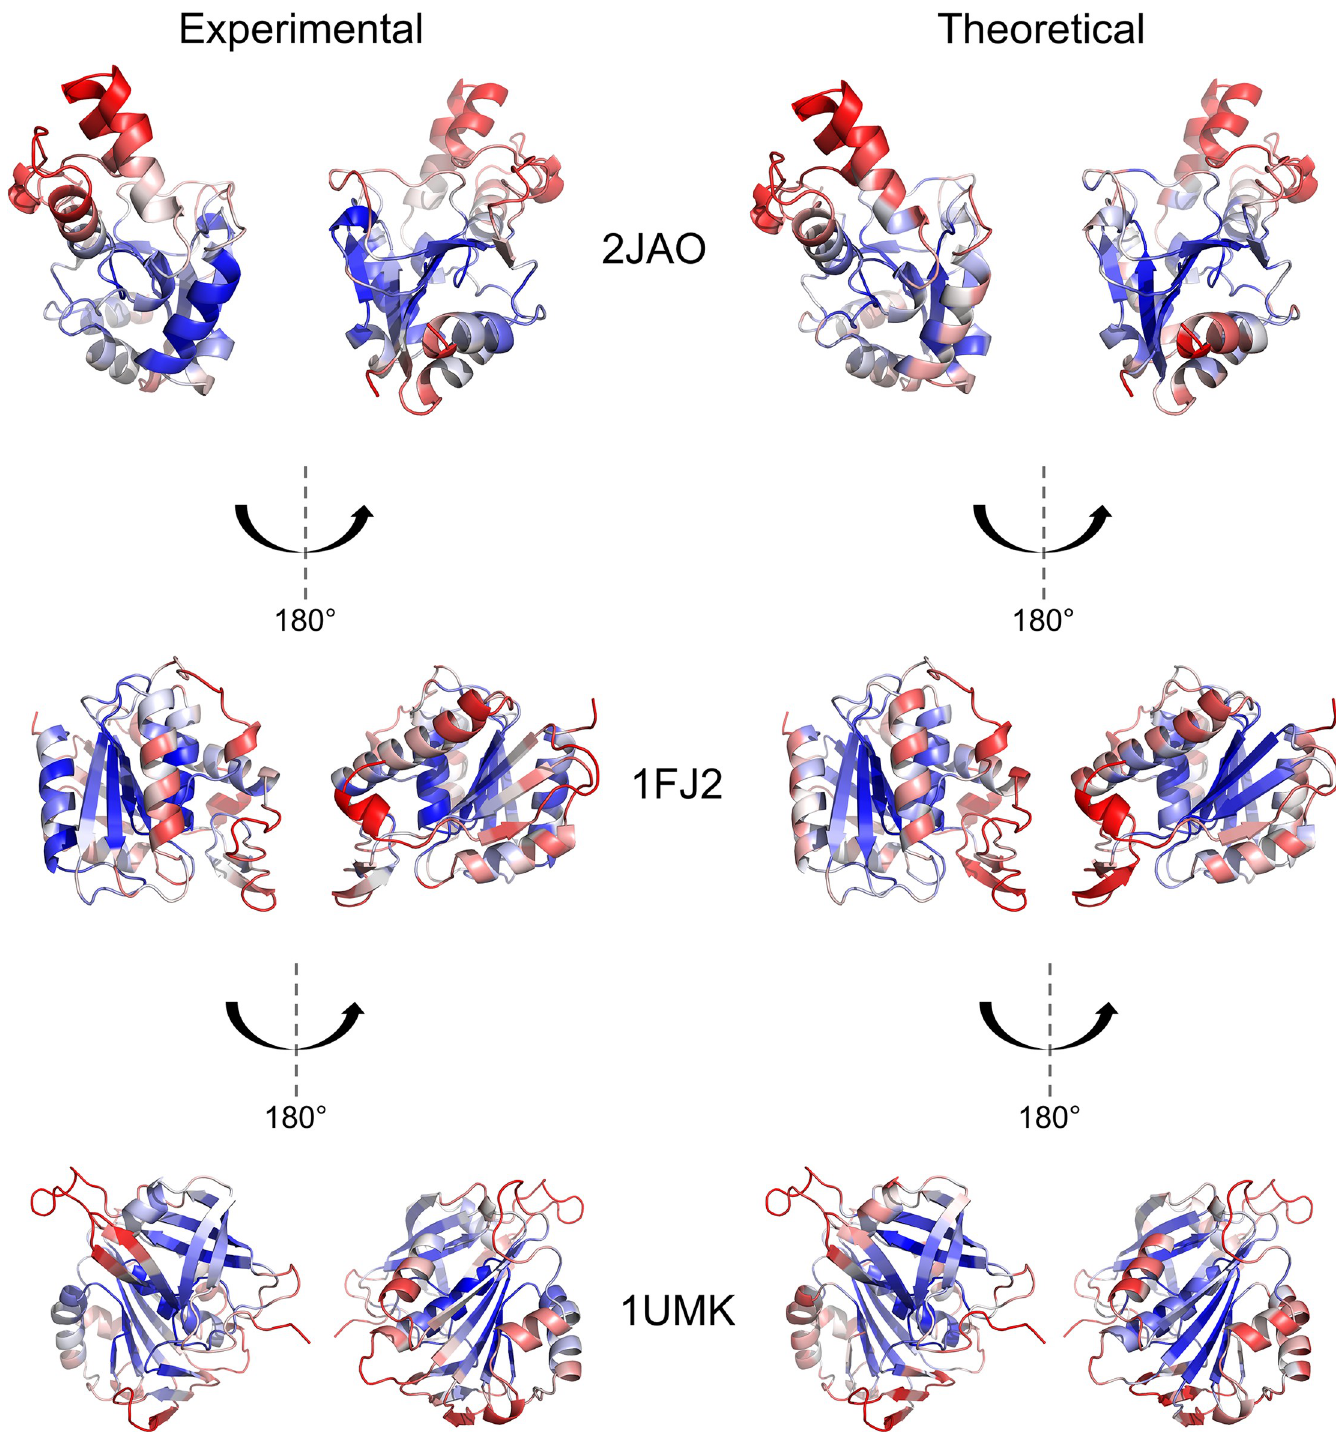
Fig 2. Color-coded ribbon diagrams using experimental and theoretical B-factors obtained by Seq-GNM. The observed crystallographic B-factors (left) and the predicted B-factors from the Seq-GNM superimposed on the structure. The three proteins selected–2JAO, 1F2J, and 1UMK–are high-resolution structures better than 2.0 Å . The B-factors are color-coded according to their B-factor profile on a spectrum of blue–white–red where blue represents the lowest B-factors (less mobility) and red represents the highest B-factors (more mobility). The B-factor scores are converted to a percentile rank so that they can be compared across different proteins. Each protein is also rotated 180˚ so that both sides can be visualized and compared. Moreover, the proteins are selected so that they have a variety of secondary structure components–2JAO contains primarily alpha helices, 1UMK is mainly composed of beta-sheets, and 1F2J is a combination of alpha helices and beta-sheets.